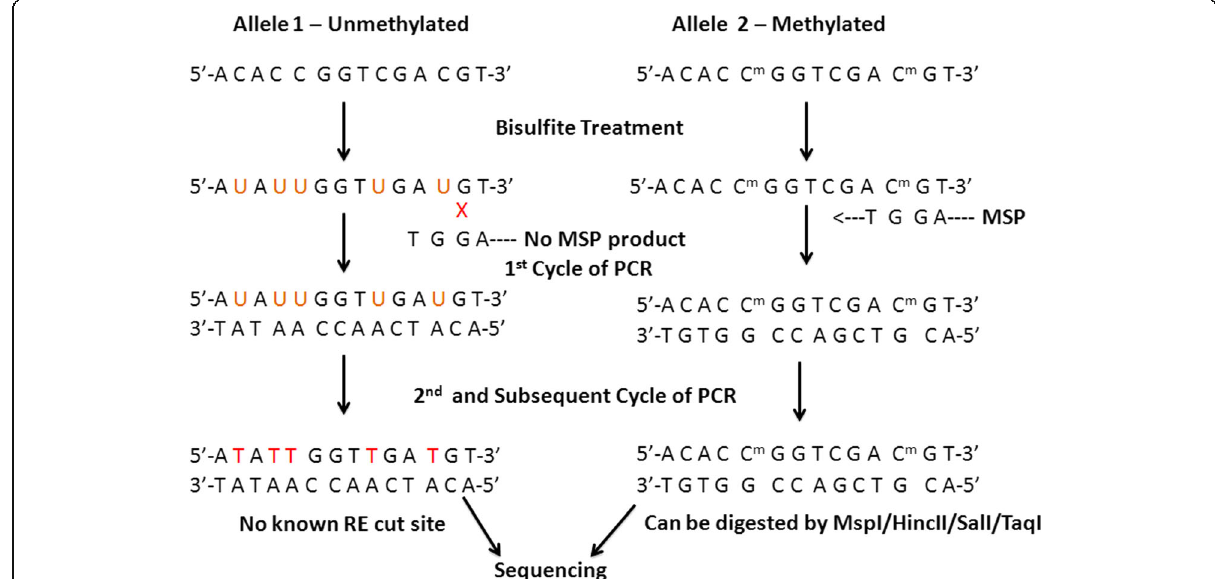
Fig. 2 Bisulfite sequencing, Methylation Specific PCR and Restriction Analysis. Methylation status of cytosines of two different samples/alleles (one methylated and another unmethylated) is detected and confirmed by bisulfite sequencing. For the genomic level of 5mC analysis, bisulfite treatment can be followed by next generation sequencing (BS-seq) method. The data obtained from bisulfite sequencing can be pursued further for Methylation Specific PCR (MSP), Combined BS Restriction Analysis (COBRA) and Methylation-sensitive Single Nucleotide Primer Extension (Ms-SNuPE, explained in Fig. 4) for routine analysis of specific cytosine